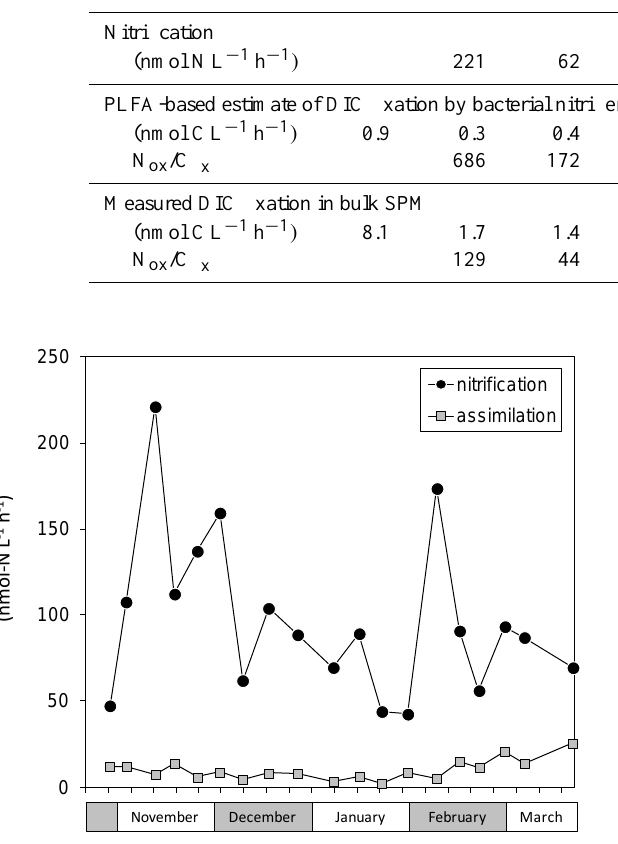
Fig. 2. Rates of nitrification and ammonium assimilation in incuba- tions with 15